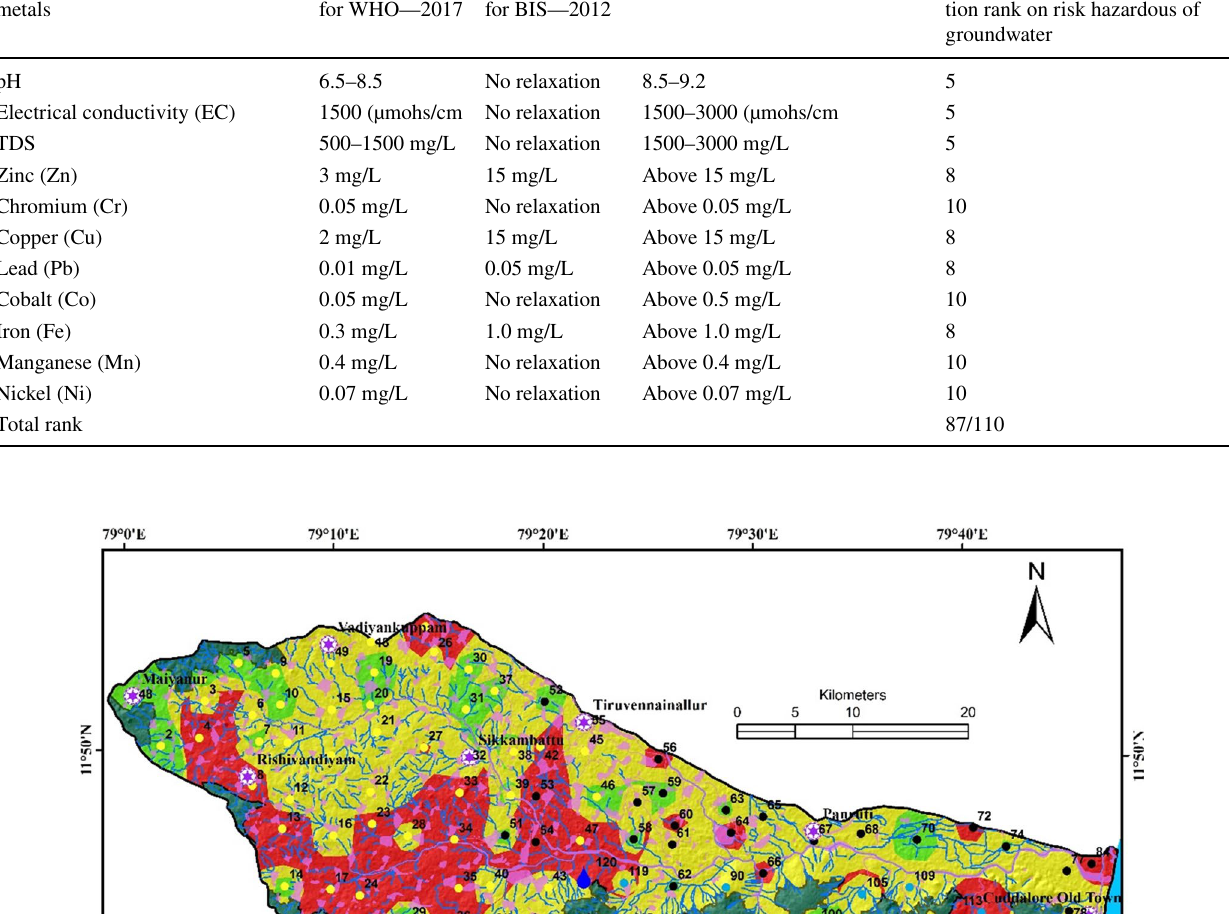
Table 8 Spatial multi-criteria Evaluation rank on risk hazardous of groundwater General parameters and heavy metals